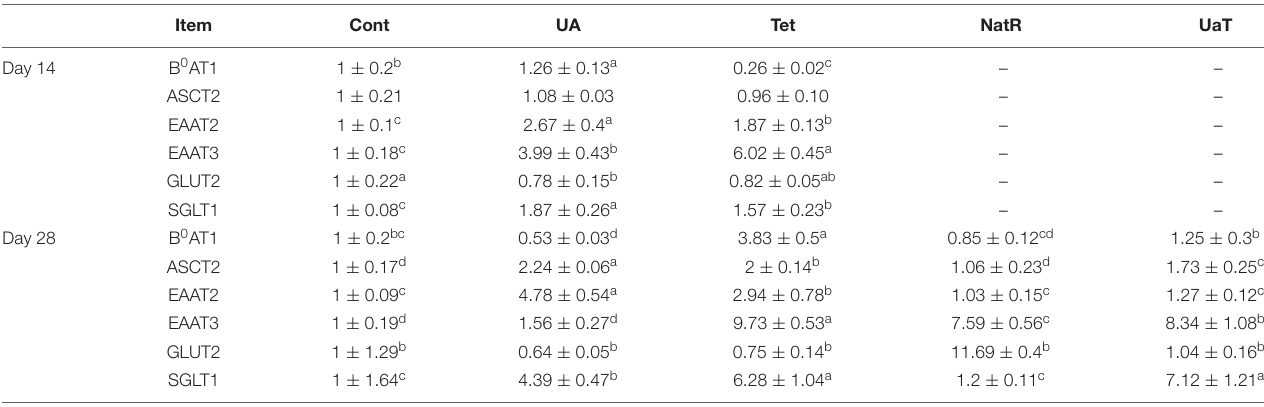
TABLE 3 | Gene expression of nutrient transporter in the jejunum of mice 1